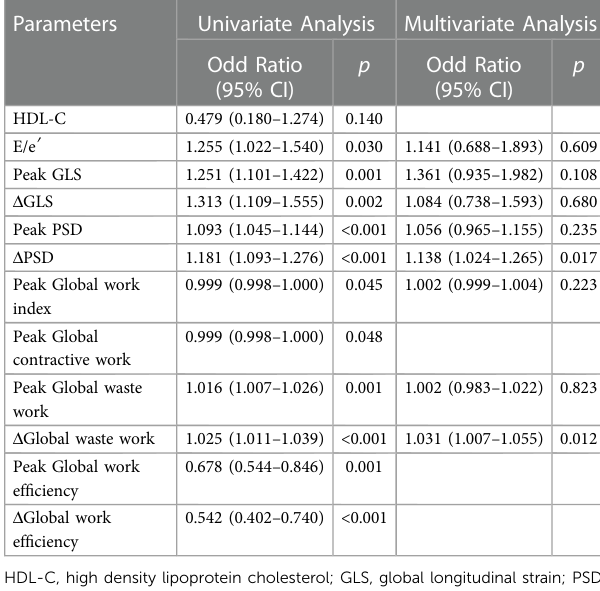
TABLE 4 Parameters linked with